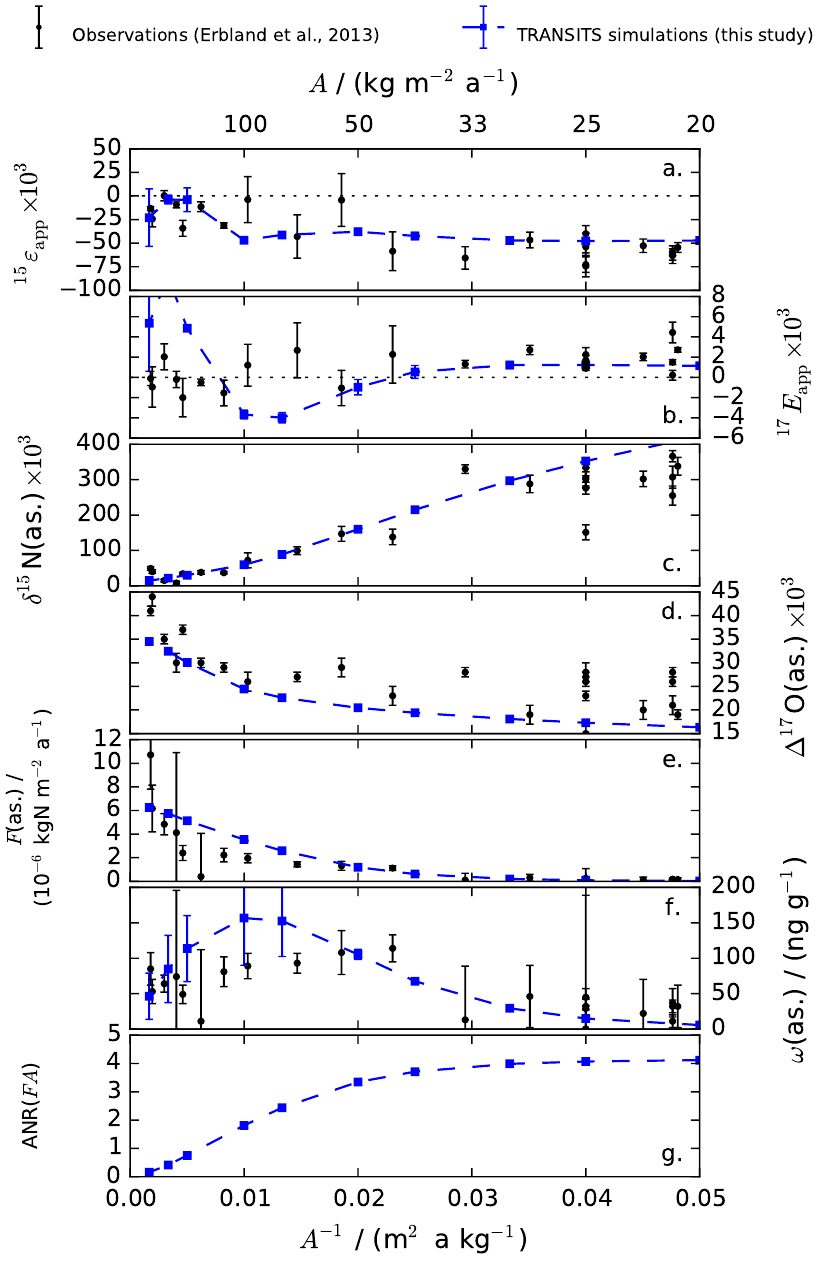
Figure 7. Reduced data in the TRANSITS simulations across East Antarctica and in the observations (Erbland et al., 2013) as a function of the snow accumulation rates (top x axis) and their inverse (bottom x axis). (a, b) 15 N / 14 N and 17 O-excess apparent fractionation constants (simulated dots and errors bars represent the mean and standard deviation values over the December/January period), (c, d) asymptotic (observed) and archived (simulated) δ 15 N and (cid:49) 17 O values (simulated dots represent annual average values), (e) asymptotic and archived nitrate mass, (f) asymptotic and archived nitrate mass fractions (simulated dots and errors bars represent the mean and standard deviation values over the whole year), and (g) average number of recyclings in the archived nitrate